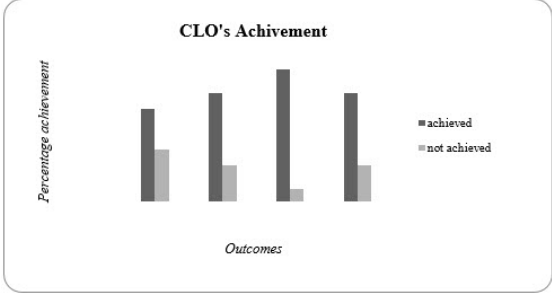
Figure 2. Course Learning Outcomes attainment